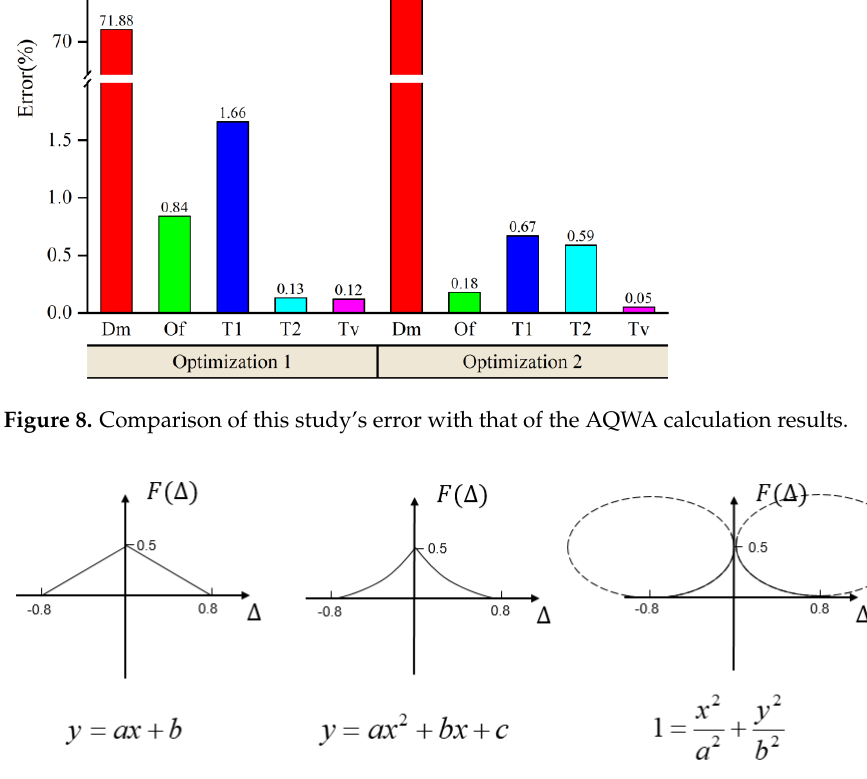
Figure 8. Comparison of this study’s error with that of the AQWA calculation results.